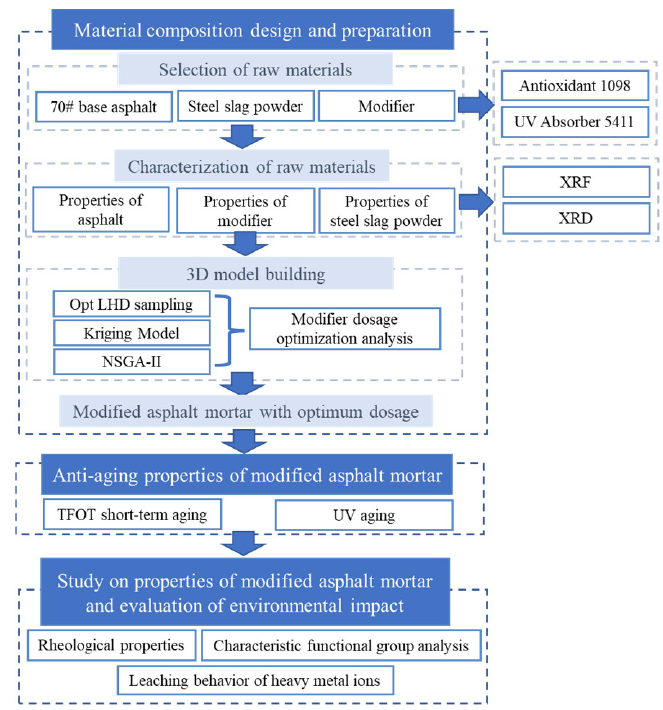
Figure 7. Experiment plan.